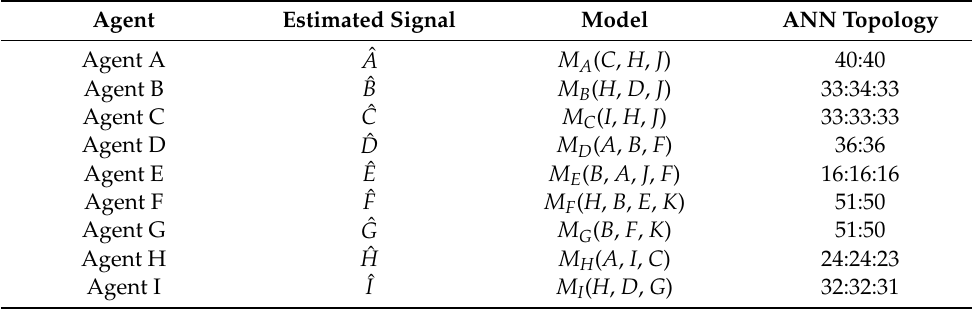
Table 4. Agents, estimated signals, and ANN models.